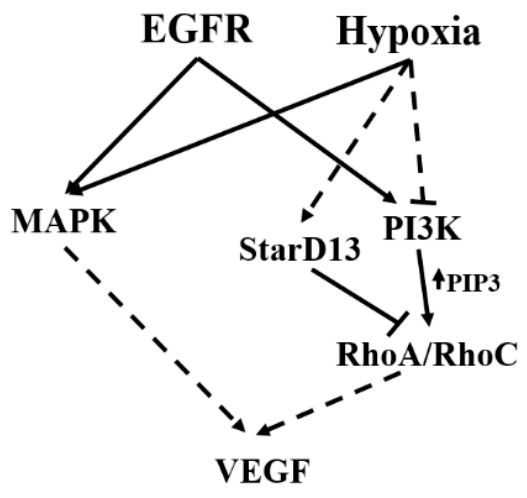
Figure 8. Model showing the pathways involved in VEGF-A expression and secretion in brain tumor cells following hypoxia and EGF stimulation. Hypoxia leads to an increase in VEGF expression and secretion in glioblastoma cells. This is through the EGF receptor and the activation of the MAPK pathway. Hypoxia also suppresses the PI3K / Rho-GTPase pathway, potentially through an increase in the expression of the RhoA GAP, StarD13. cells. Figure S2: Di ff erent hypoxic conditions. Figure S3: Hypoxia does not a ff ect the expression of RhoA or RhoC in astrocytoma cells. Figure S4: Hypoxia-induced increase in VEGF expression is ERK-dependent but PI3K-independent even in the absence of serum in astrocytoma cells. Figure S5: Hypoxia does not a ff ect the activation of Cdc42 in astrocytoma